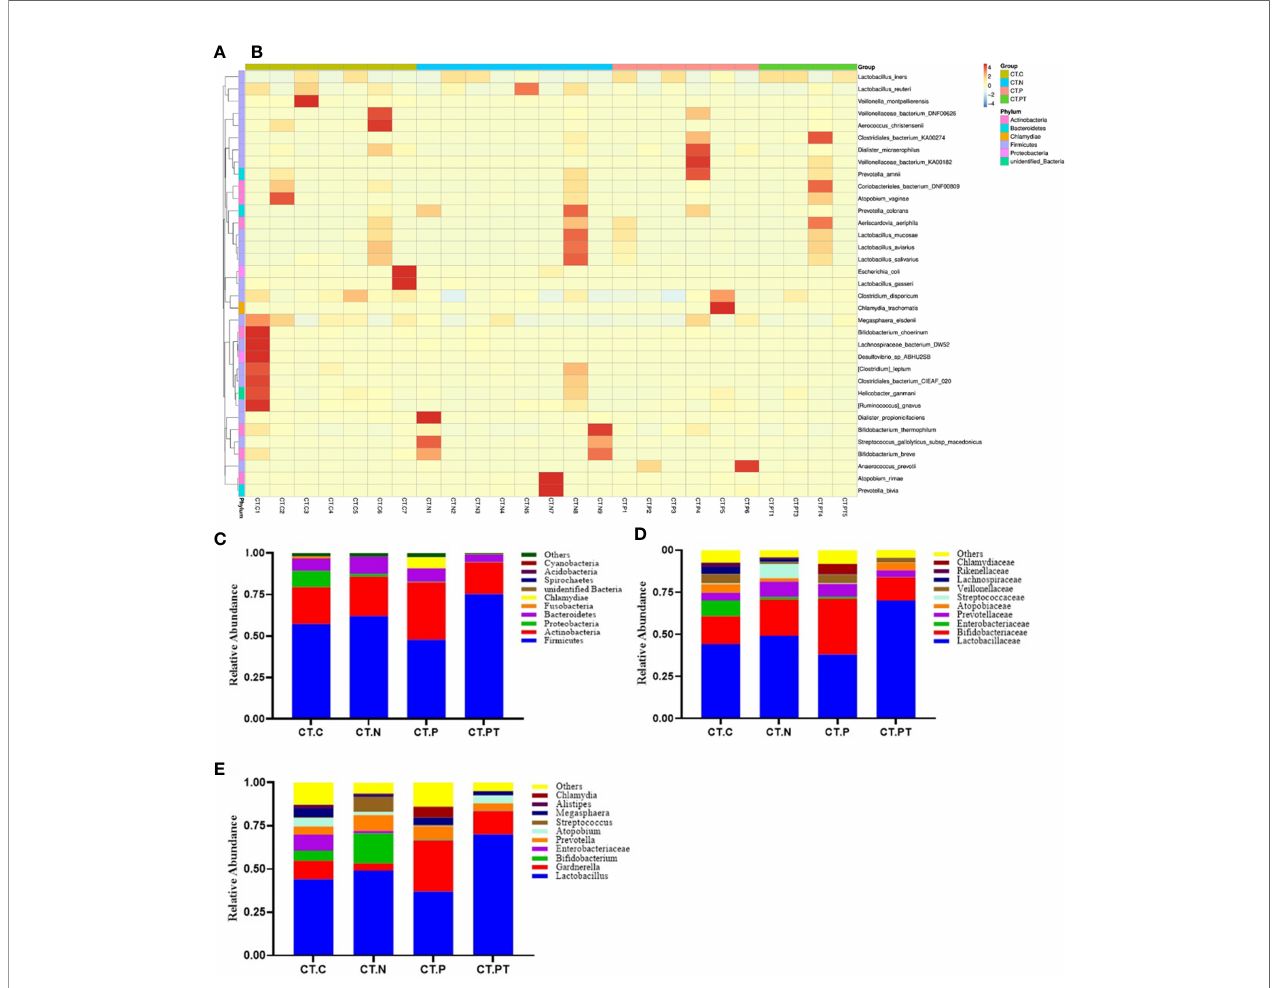
FIGURE 3 | Taxonomic composition of the vaginal microbiota. (A) Complete linkage clustering of sample relationships generated from Bray – Curtis dissimilarity matrix. (B) Heatmap of the log10-transformed proportions of the top 35 bacterial taxa, in terms of relative abundance, found in the vaginal microbiota. Stacked bar charts of top 10 taxa in terms of relative abundances at (C) phylum, (D) family, and (E) genus level for each group. Remaining taxa are grouped in the “ Other ” category. CT-C, women from the physical examination center (PEC) who were healthy and C. trachomatis -negative; CT-N, women who were infertile and C . trachomatis -negative from the assisted reproductive technology center (ART); CT-P, women who were infertile and C . trachomatis -positive from the ART; CT-PT, CT-P women post-treatment with